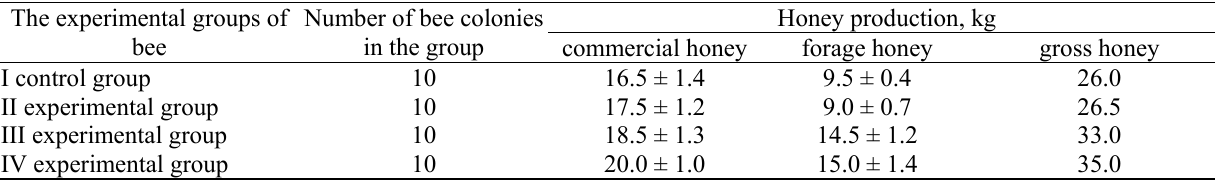
Productivity of Honey Bee Colonies The experimental groups of